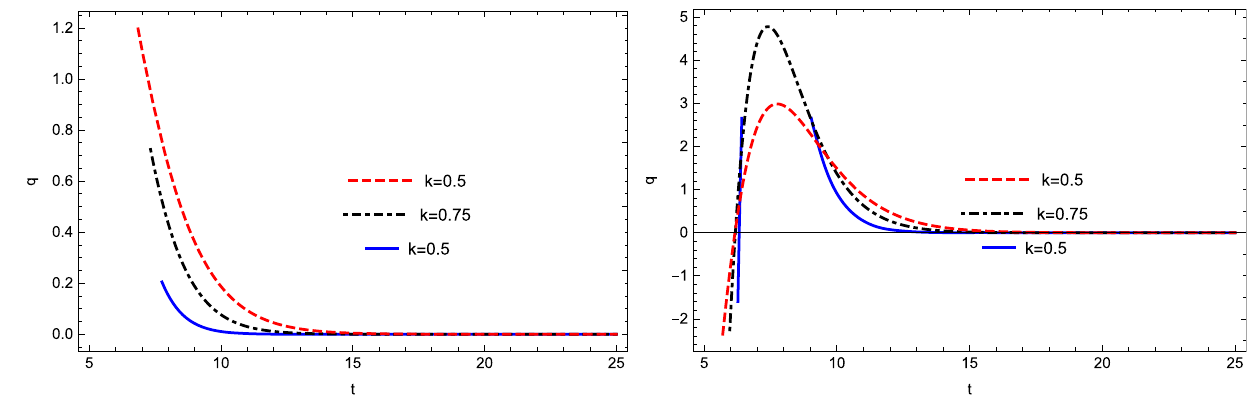
u = 2 . 002 in the right plot of Fig. 1. In this regard, it pro-